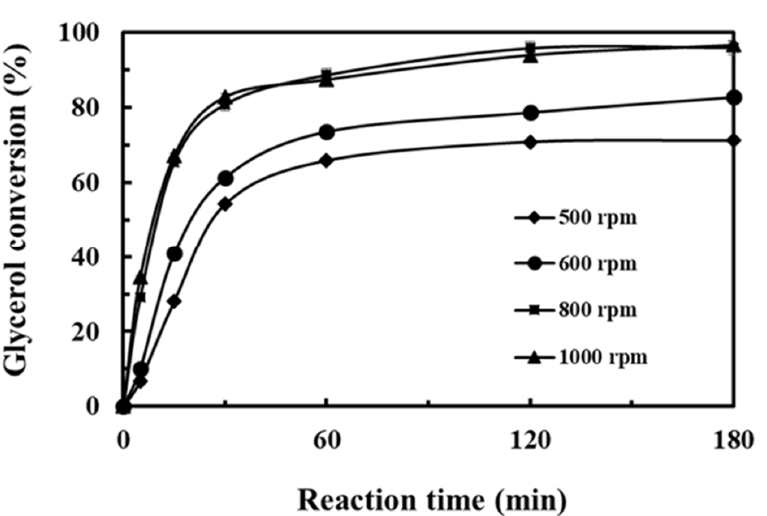
Figure 2. Effect of stirring speeds of conventional magnetic stirrer on glycerol conversion. Reaction condition: molar ratio of DMC: glycerol = 2.5, catalyst loading = 4.8 wt%, reaction temperature = 60 °C, reaction time = 180 min.